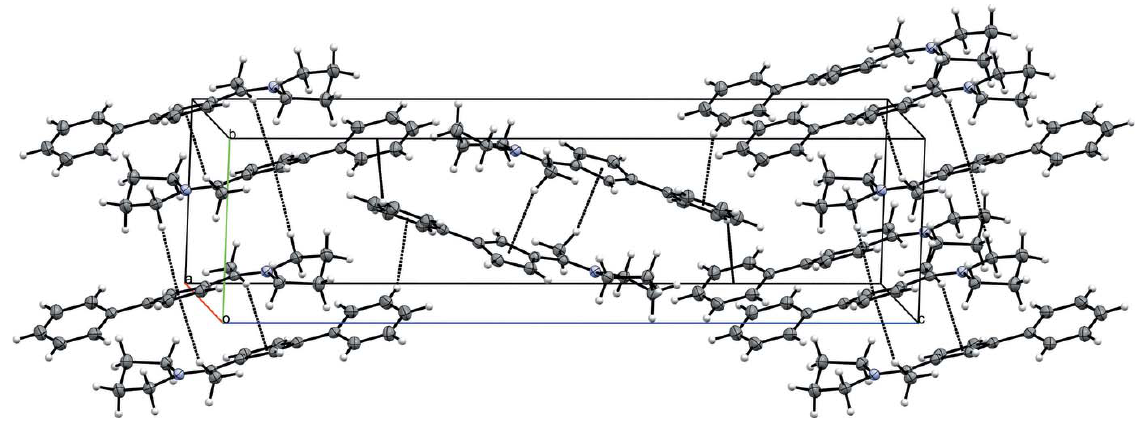
Figure 2 The crystal packing of the title compound, viewed along the a axis. Displacement ellipsoids are shown at the 50% probability level. C—H (cid:2)(cid:2)(cid:2) (cid:2) ring interactions are shown as dashed